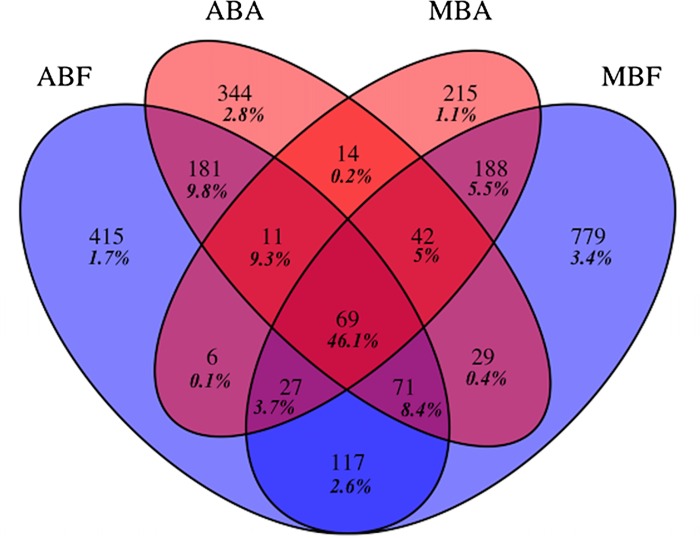
Venn diagram showing the unique and shared OTUs after normalization to the smallest sample (n = 3402 reads).(AB) for Anabaena bloom, (MB) for Microcystis bloom and (F) for free living fraction and (A) for the associated fraction. Relative proportions of those OTUs are shown in bold italic.